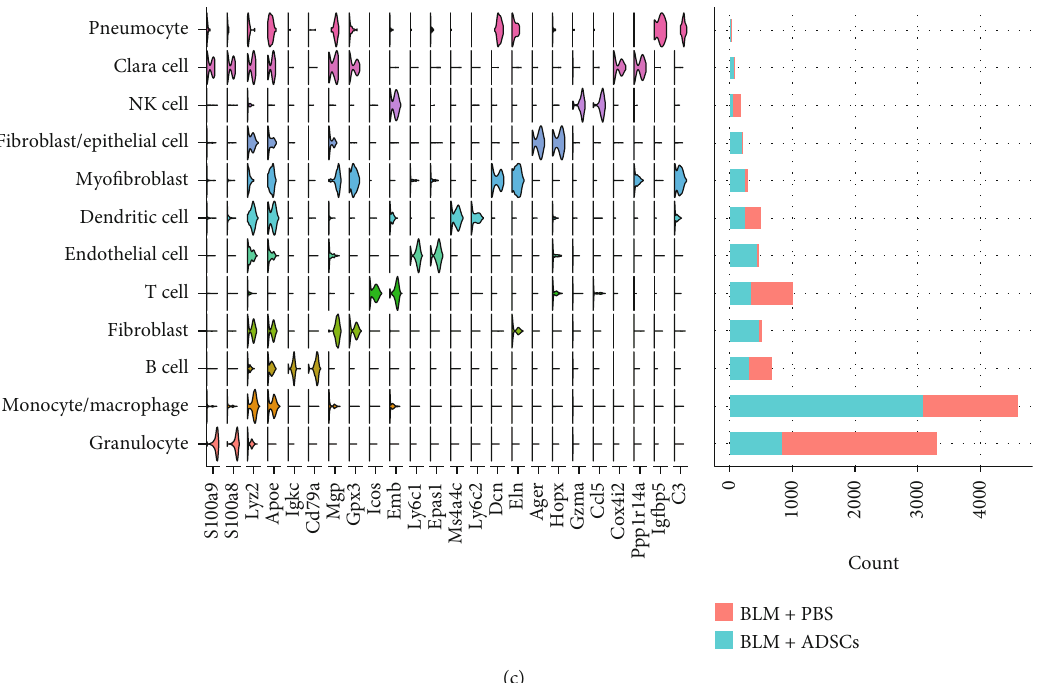
Figure 2: Injected ADSCs greatly changes single-cell heterogeneity of BLM-treated lung tissue. (a) Flow cytometry diagrams for sorting of digested lung tissue based on GFP signal intensity. Left: BLM + PBS group, as non-GFP control for lung-originated cells only. Right: BLM + ADSCs group, showing a small population of GFP+ cells, which are considered recollected ADSCs. (b) UMAP plot of lung-originated cell scRNA-seq data, merging cells from the BLM + ADSCs group and BLM + PBS group. Left: dots colored by group. Right: dots colored by SingleR annotated cell type based on clusters identi fi ed by Seurat. (c) Stacked violin plot of cluster marker genes (three marker genes for each cluster) and cell count number for each cluster of lung-originated